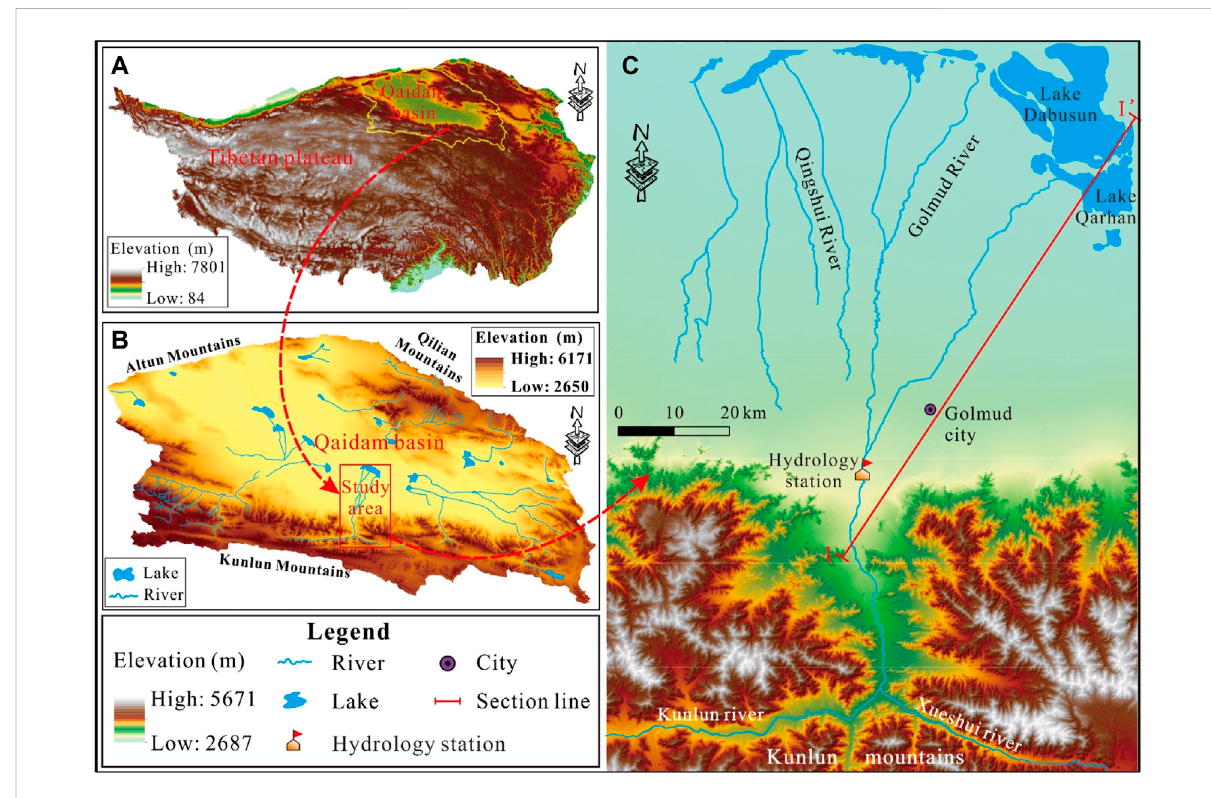
FIGURE 1 Location of (A) the Tibetan Plateau, (B) the Qaidam Basin, and (C) the Golmud river